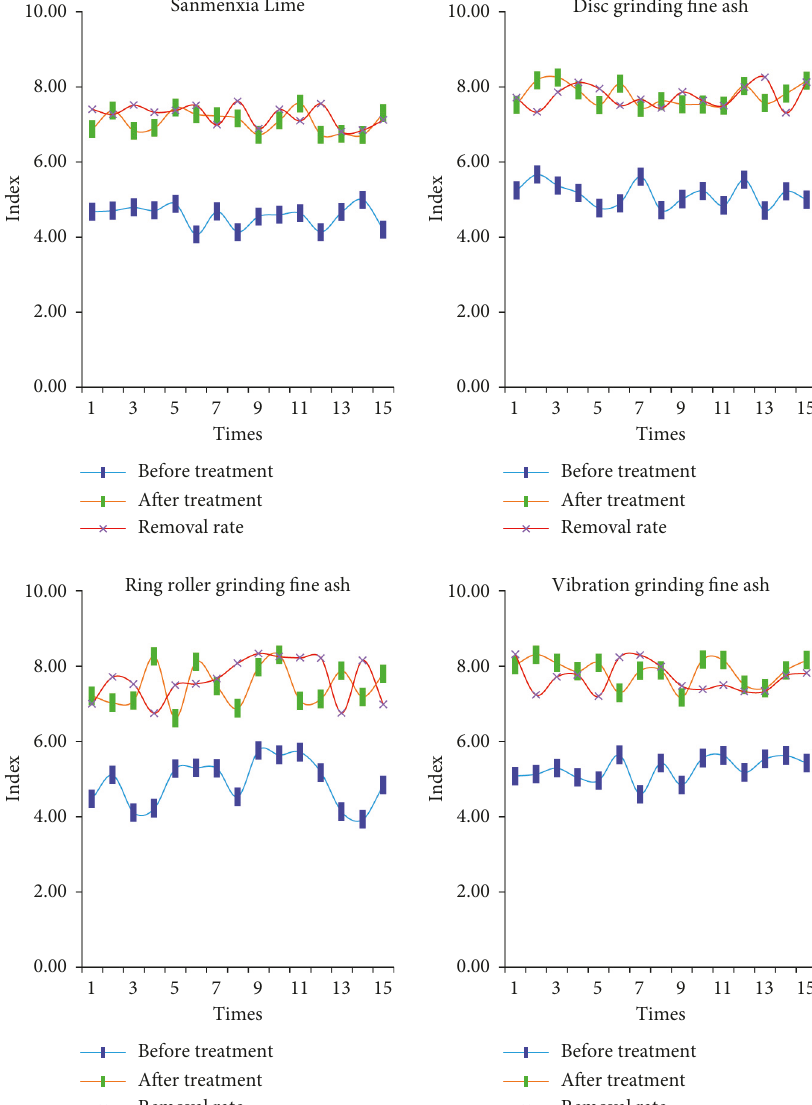
Figure 7: Iron electrode electrocoagulation method participates in the treatment of fly